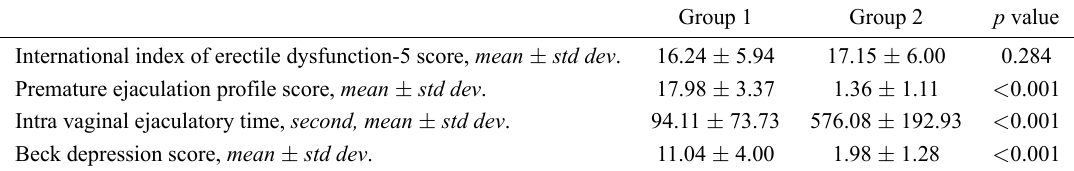
Table 2. Comparison of questionary scores of patients according to the groups.